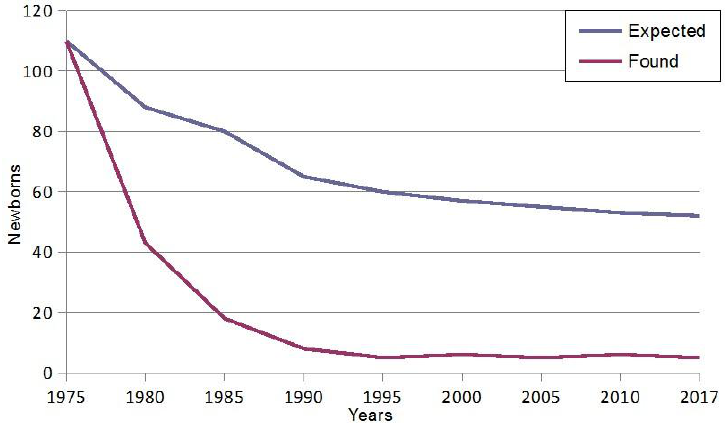
Table 5. Acceptance of prenatal diagnosis of β-thalassemia according to the invasive procedures. Technique